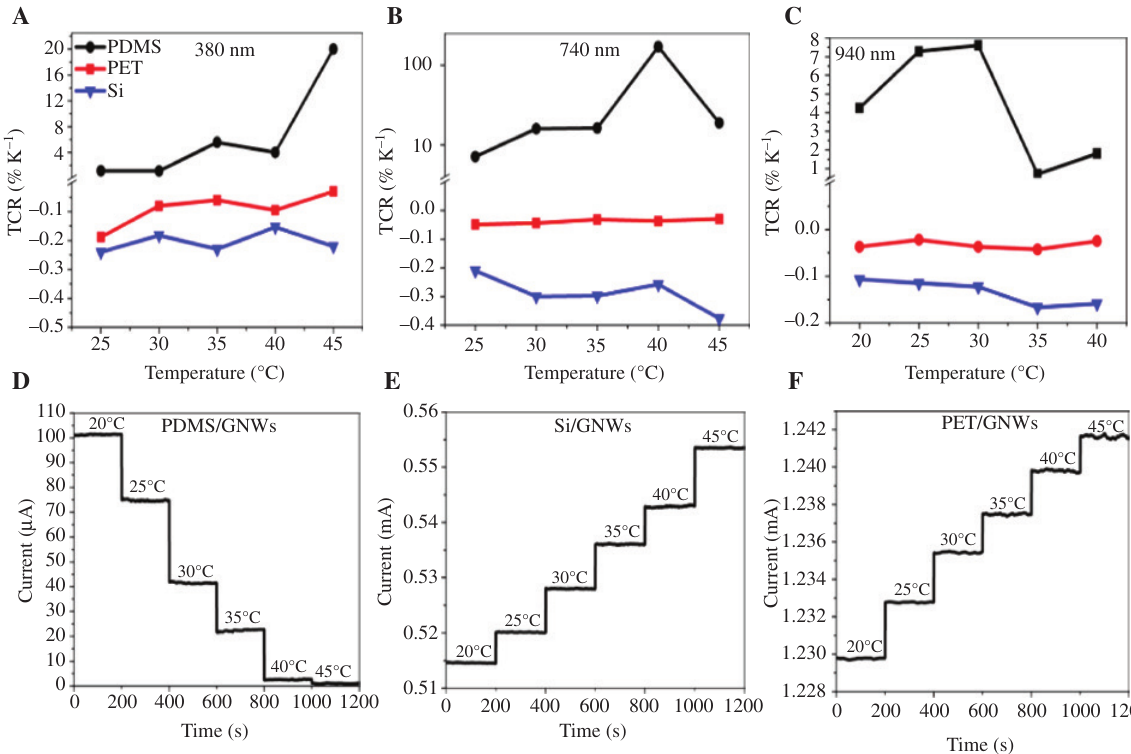
Figure 3: Influence of different CTEs of the substrate on CTR. (A–C) TCR as a function of temperature with different substrates. The height of the GNWs is 380, 740, and 940 nm, respectively. (D–F) Current variation tendency of the GNWs (740 nm) at different temperatures on PDMS, Si, and PET substrate,